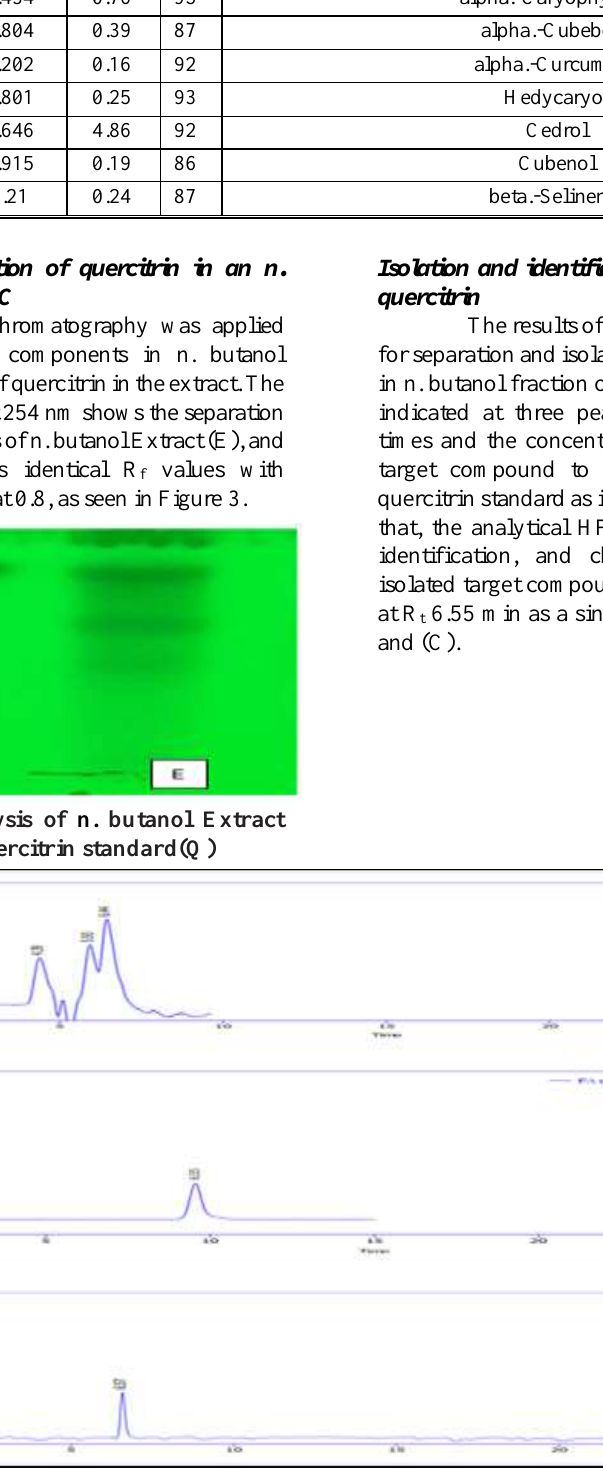
Figure 4. The HPLC chromatogram (A): n. butanol fraction of C. sempervirens leaves; (B): Isolated target compound (quercitrin ); (C): quercitrin